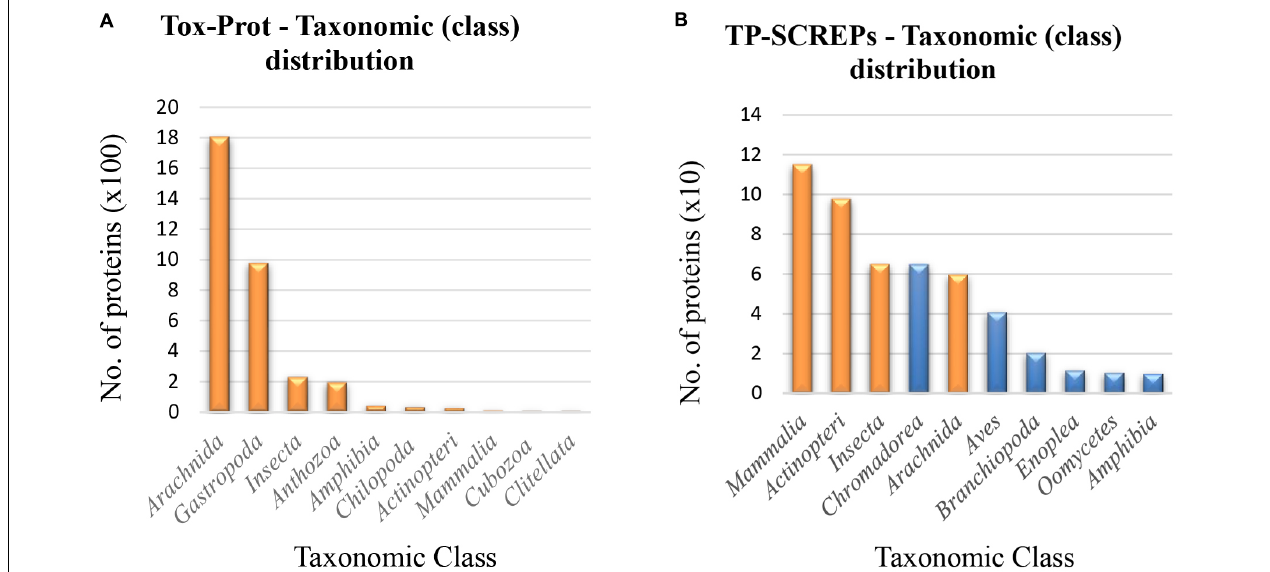
FIGURE 7 | Taxonomic distribution of Tox-Prot and TP-SCREPs. (A) The taxonomic distribution of classes within the refined Tox-Prot dataset. (B) The taxonomic distribution of SCREPS that display homology with the refined Tox-Prot dataset “TP-SCREPs,” orange indicating the overlap of taxonomic class with Tox-Prot.